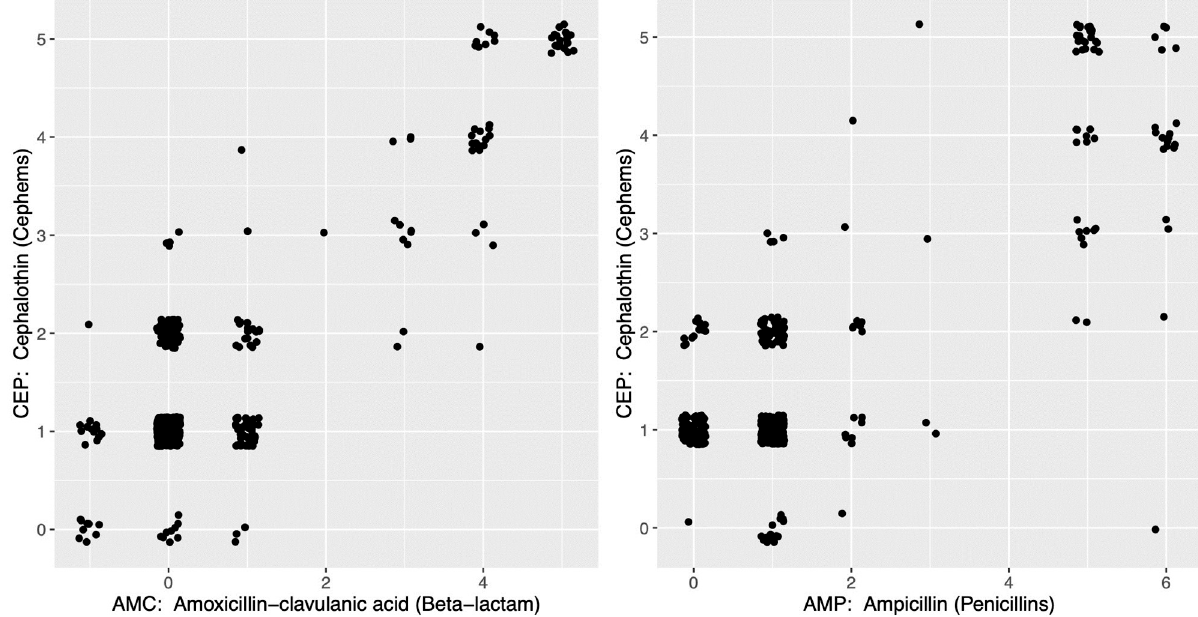
Fig 2. Scatter plots of the observed log 2 MIC (MIC in unit μ g/mL) with jittering of Salmonella heidelberg isolates tested by AMC & CEP (left) and AMP & CEP (right) in NARMS human population during 1996-2003.